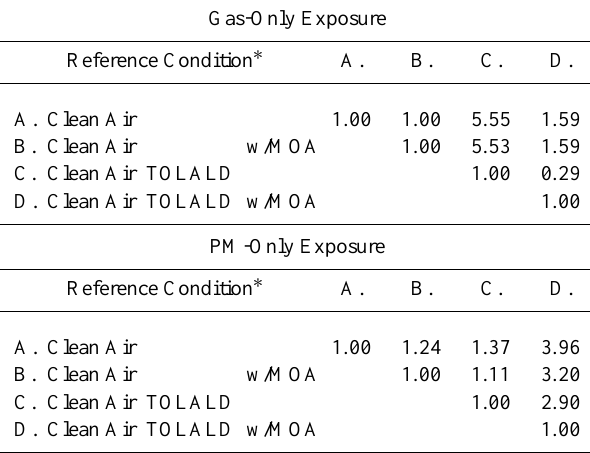
Table 2. Ratios of measured inflammatory responses (IL-8) for in vitro human lung cell exposures to TOLALD mixtures, (Table 1 and Fig. 4).